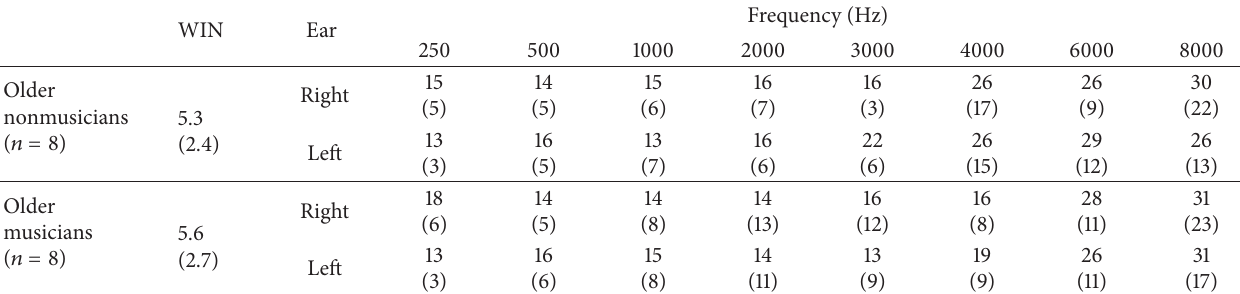
Table 2: Mean pure-tone hearing thresholds (dBHL) and 50% signal-to-noise ratios (dB) for the Words-in-Noise (WIN; [38, 39]) test plus standard deviations for each older participant